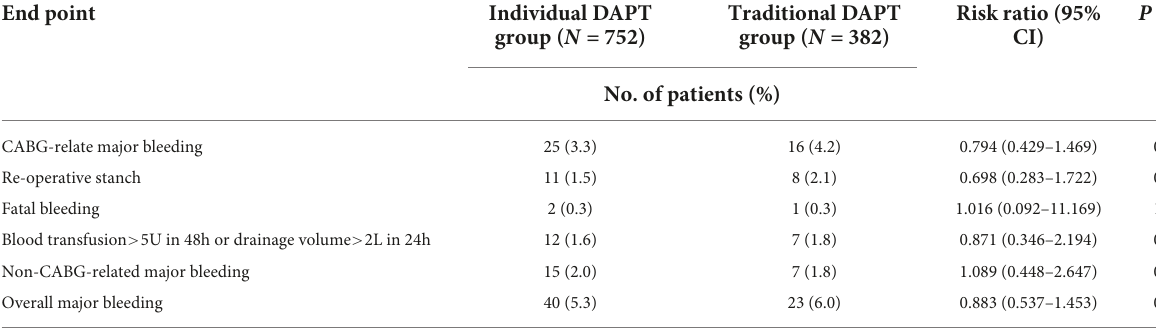
TABLE 4 Safety endpoints of individual dual antiplatelet therapy (DAPT) group vs. traditional DAPT group.